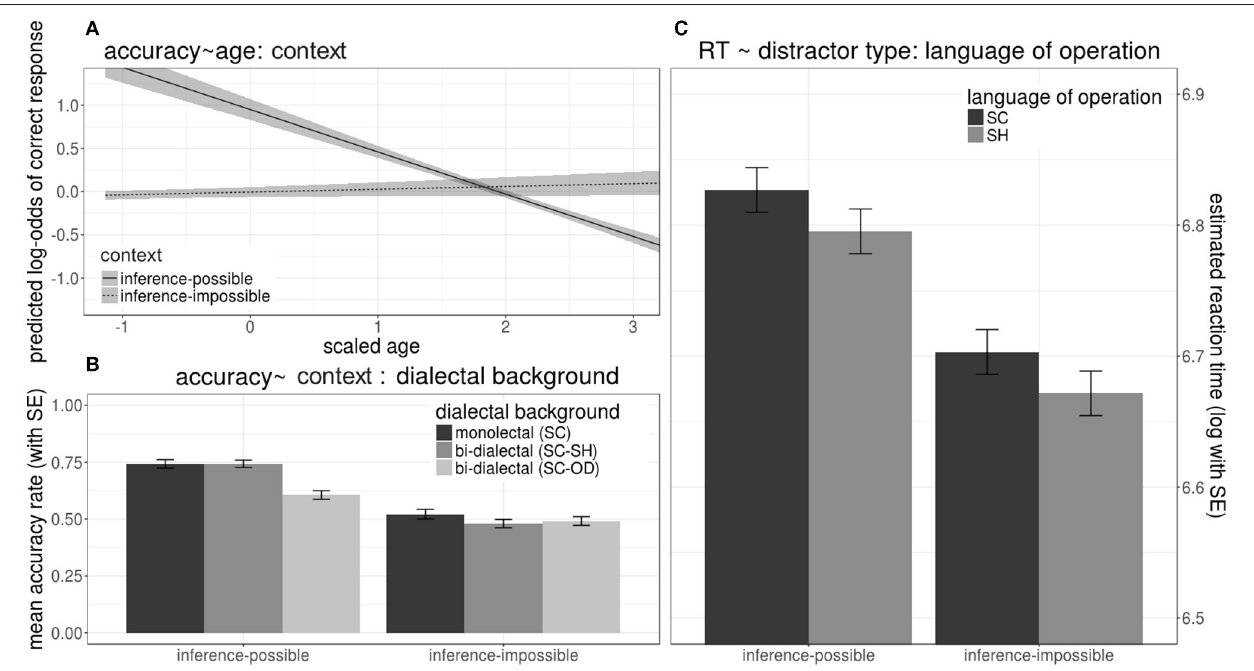
FIGURE 9 | Effects on mean accuracy rates (A,B) (left panels) and reaction times (C) (right panels) in response to noise trials during lexical identification test, including (1) interaction of age and context provided by the distractor on accuracies (upper left panel), (2) interaction of dialectal background and context provided by the distractor on accuracies (lower left panel), (3) effects of dialectal background and context provided by the distractor on reaction times (right panel).